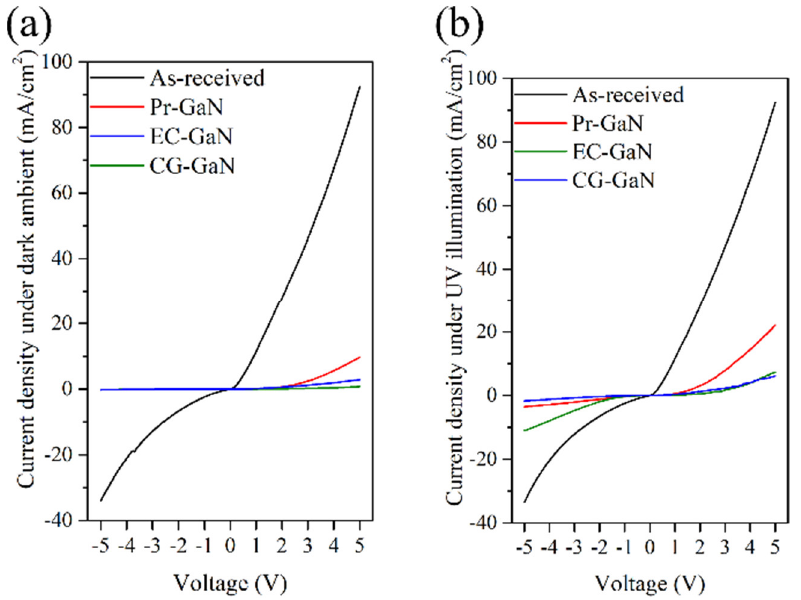
Figure 5. J–V characteristics of UV photodetectors operating under ( a ) dark and ( b ) UV ambient.